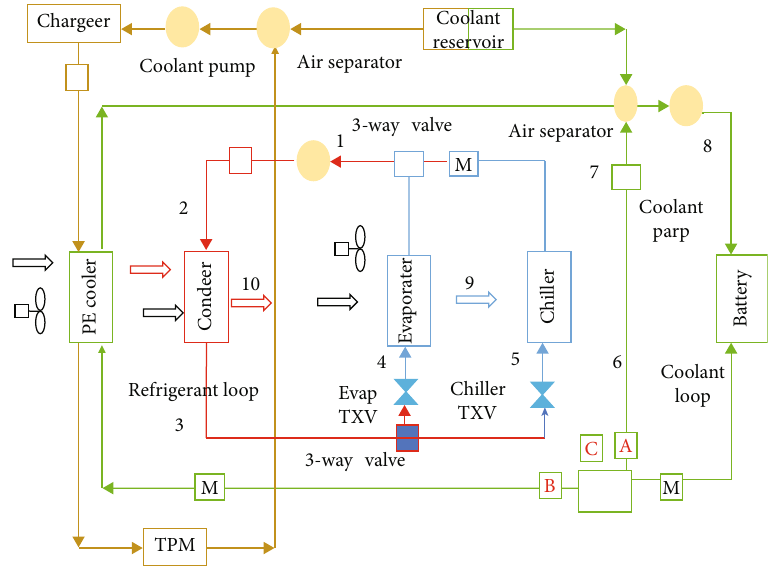
Figure 1: Integrated thermal management control system for new energy